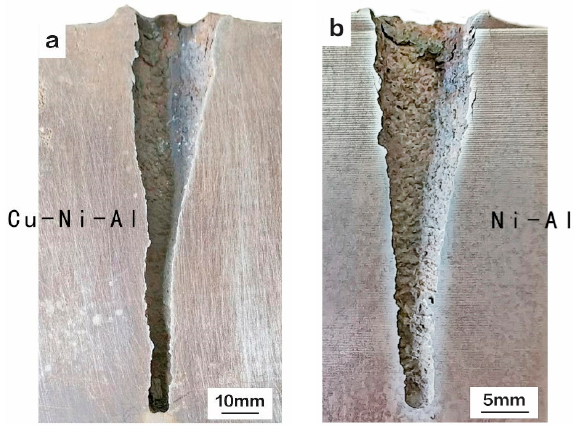
Figure 5. The point EDS results of A-E.